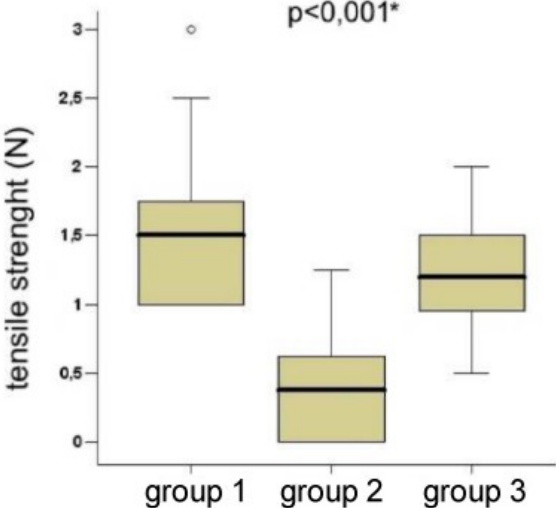
FIGURE 6 - Comparison of tensile strengths across